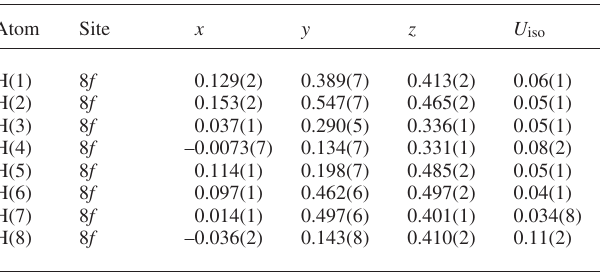
Table 2. Atomic coordinates and displacement parameters (in Å 2 )